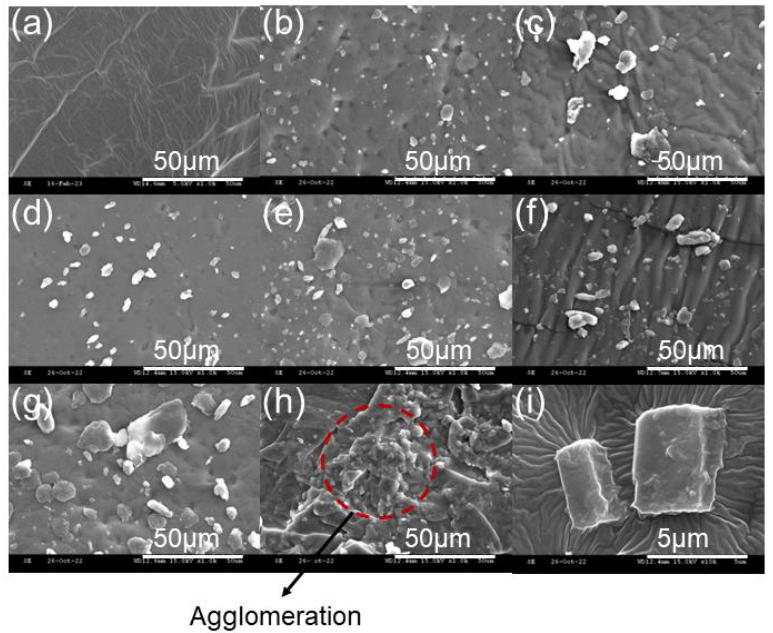
Figure 2. SEM microphotographs of the F-LSR-POSSs: ( a ) F-LSR-raw, ( b ) F-LSR-V0-0.5, ( c ) F-LSR- V4-0.5, ( d ) F-LSR-V6-0.5, ( e ) F-LSR-V8-0.5, ( f ) F-LSR-V8-1, ( g ) F-LSR-V8-2.5, ( h ) F-LSR-V8-5, and ( i ) magnified crosslinked POSS.